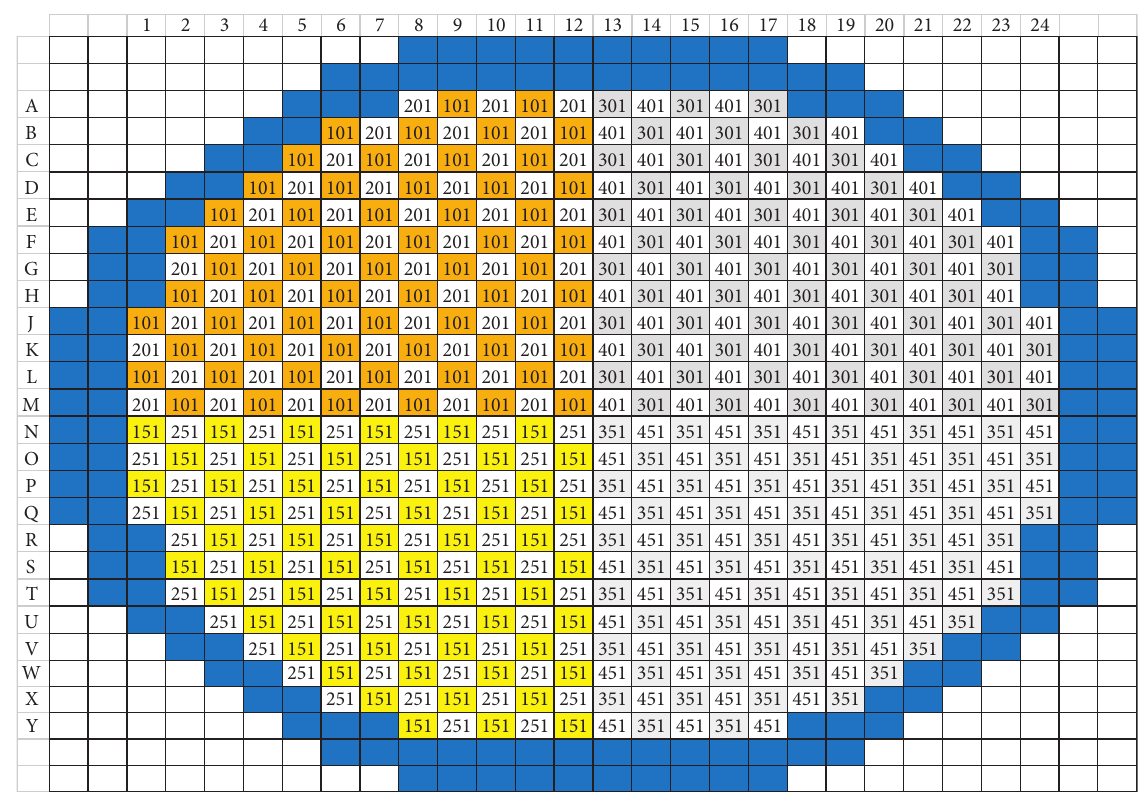
Figure 7: Fuel channel radial nodalization and mapping—reflector cells shown in